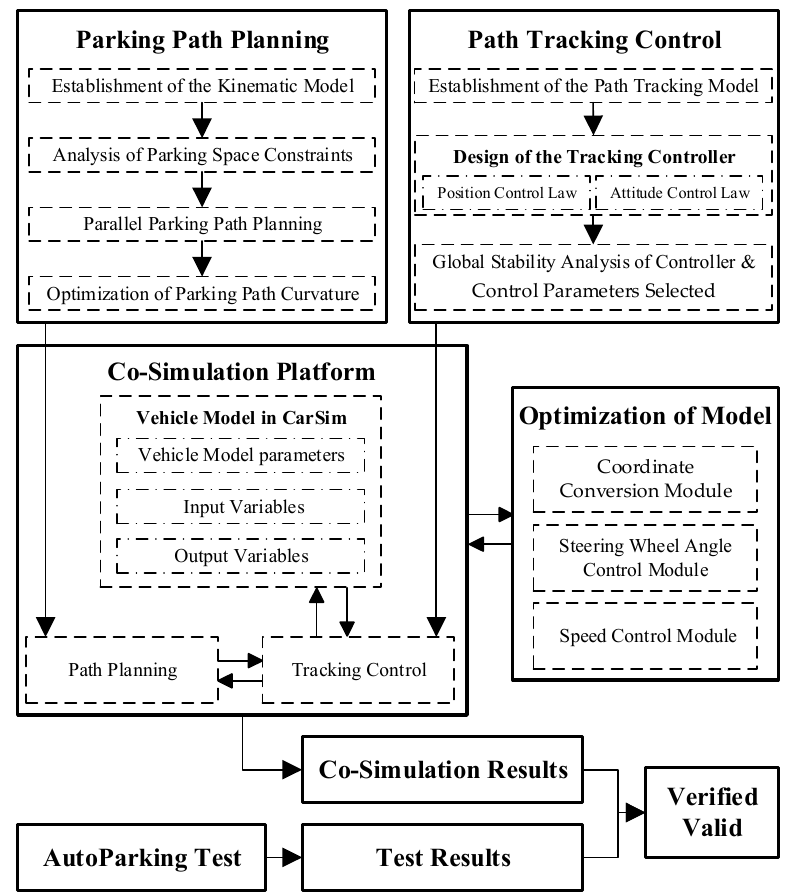
Figure 1. Flowchart of the Research Methodology.